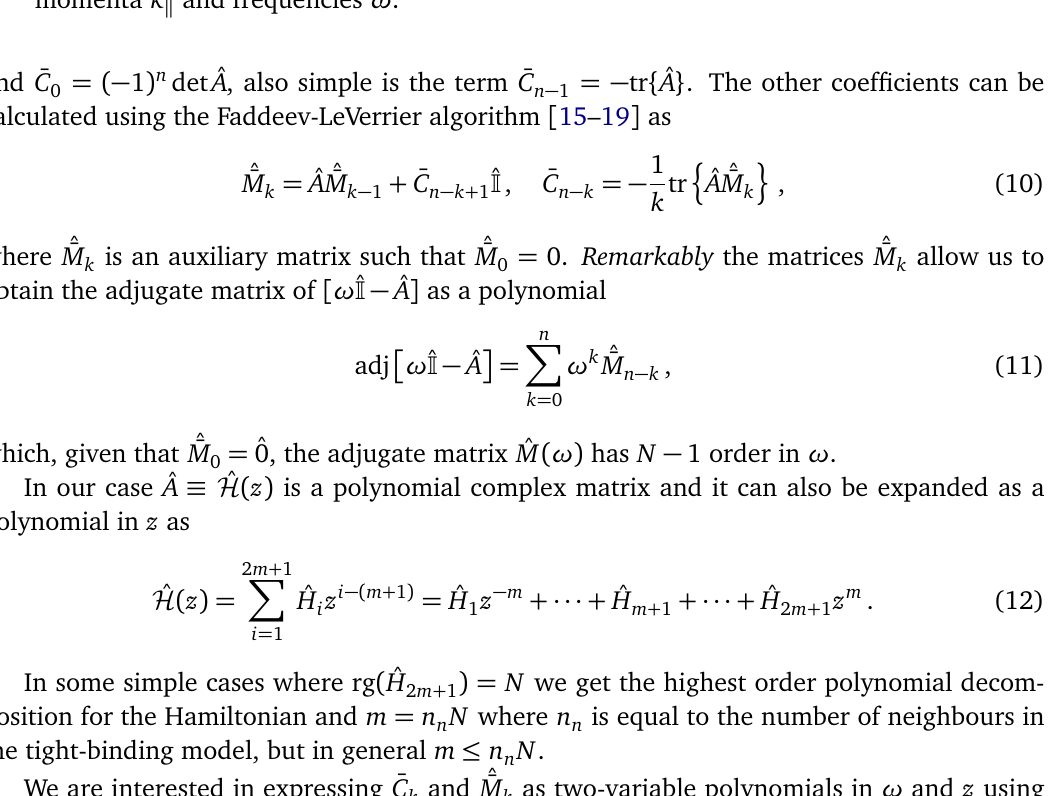
Figure 2: Complete algorithm workflow to compute the bGF using the FLA where the main input is the polynomial decomposition of the Hamiltonian for a given set of momenta k (cid:107) and frequencies ω